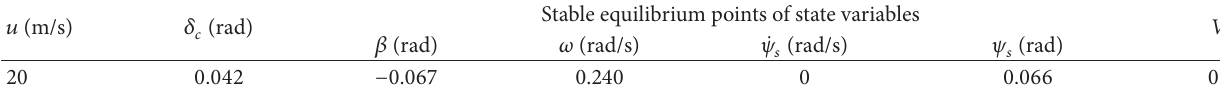
Table 3: Critical values of 𝑉(𝑥) .